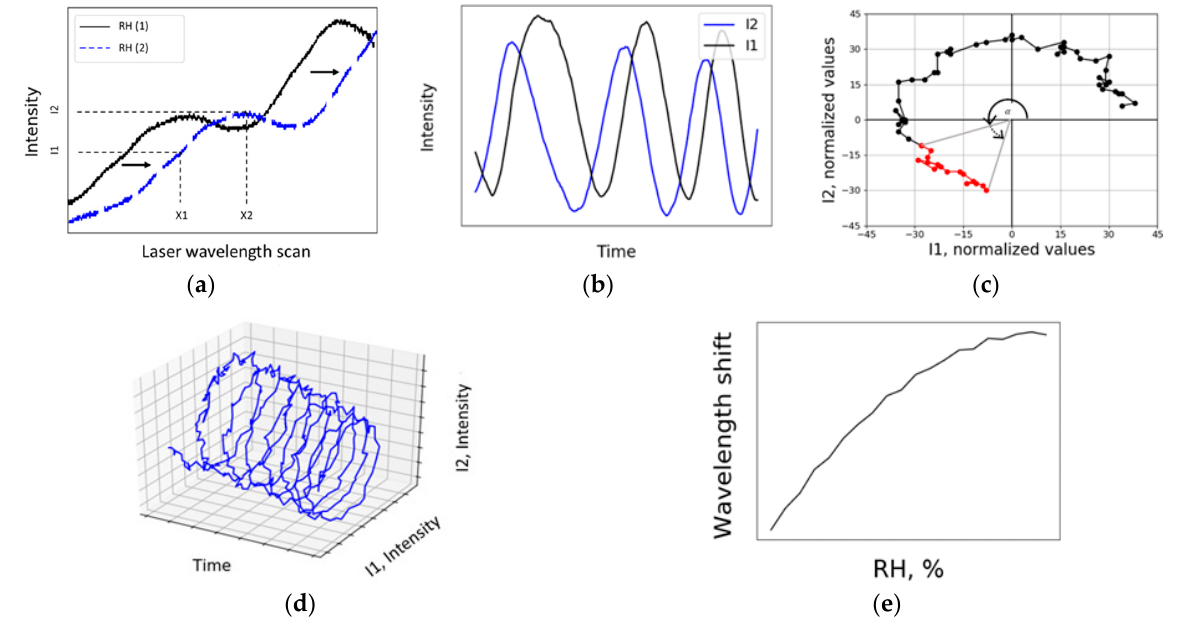
Figure 4. Illustrative principal steps of the data analysis method. The intensity was continuously recorded at two waveform points and Lissajous figure was plotted: ( a ) WGM resonance spectrum where the blue, dotted curve shows a shift to the right due to increase in RH. The black curve shows the resonance position at some initial RH. The intensity was recorded at points X1 and X2. Thus, I1 = f(X1) and I2 = f(X2); ( b ) As RH changed and modes shifted by, sinusoidal graphs were recorded. Sinusoidal functions reach their minimum when resonance peaks pass points X1 and X2. However, it is impossible to know if the humidity is increasing or decreasing from this graph; ( c ) Values I1 and I2 were normalized to create a circle (Lissajous figure) around the origin point (0, 0). By knowing X and Y projections (normalized I1 and I2 values), a radius vector could be constructed and an angle α could be determined. As RH increased, the angle α also increased and represented the shift in wavelength. The direction in which the normalized Lissajous figure is rotating determines whether RH is increasing or decreasing, while the modulus of angle α (which corresponds to wavelength shift) determines how much RH has changed; ( d ) 3D plot shows I1 and I2 in the time domain. Spiral-like structure was analyzed as a Lissajous figure; ( e ) Result of data processing—accumulated wavelength shift due to change in RH.